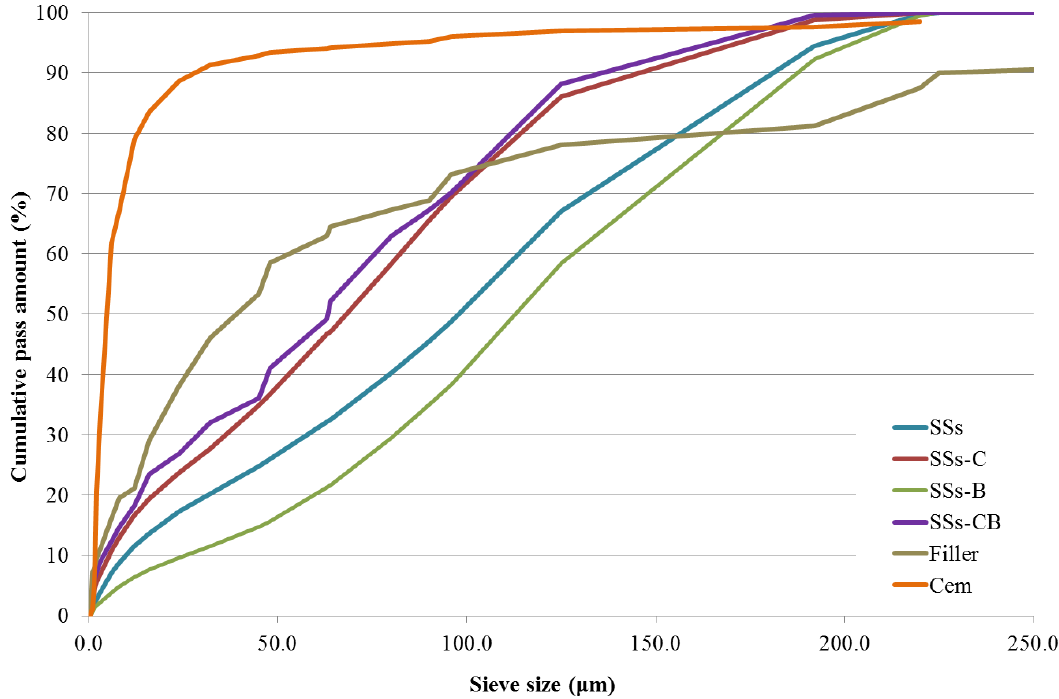
Figure 1. Particle size distribution of SSs and Filler.